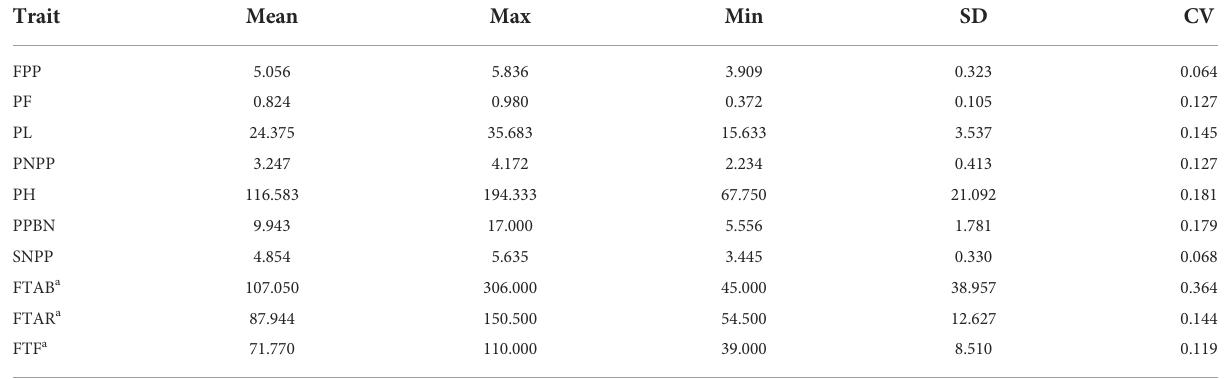
TABLE 1 Statistical analysis of eight rice yield-related